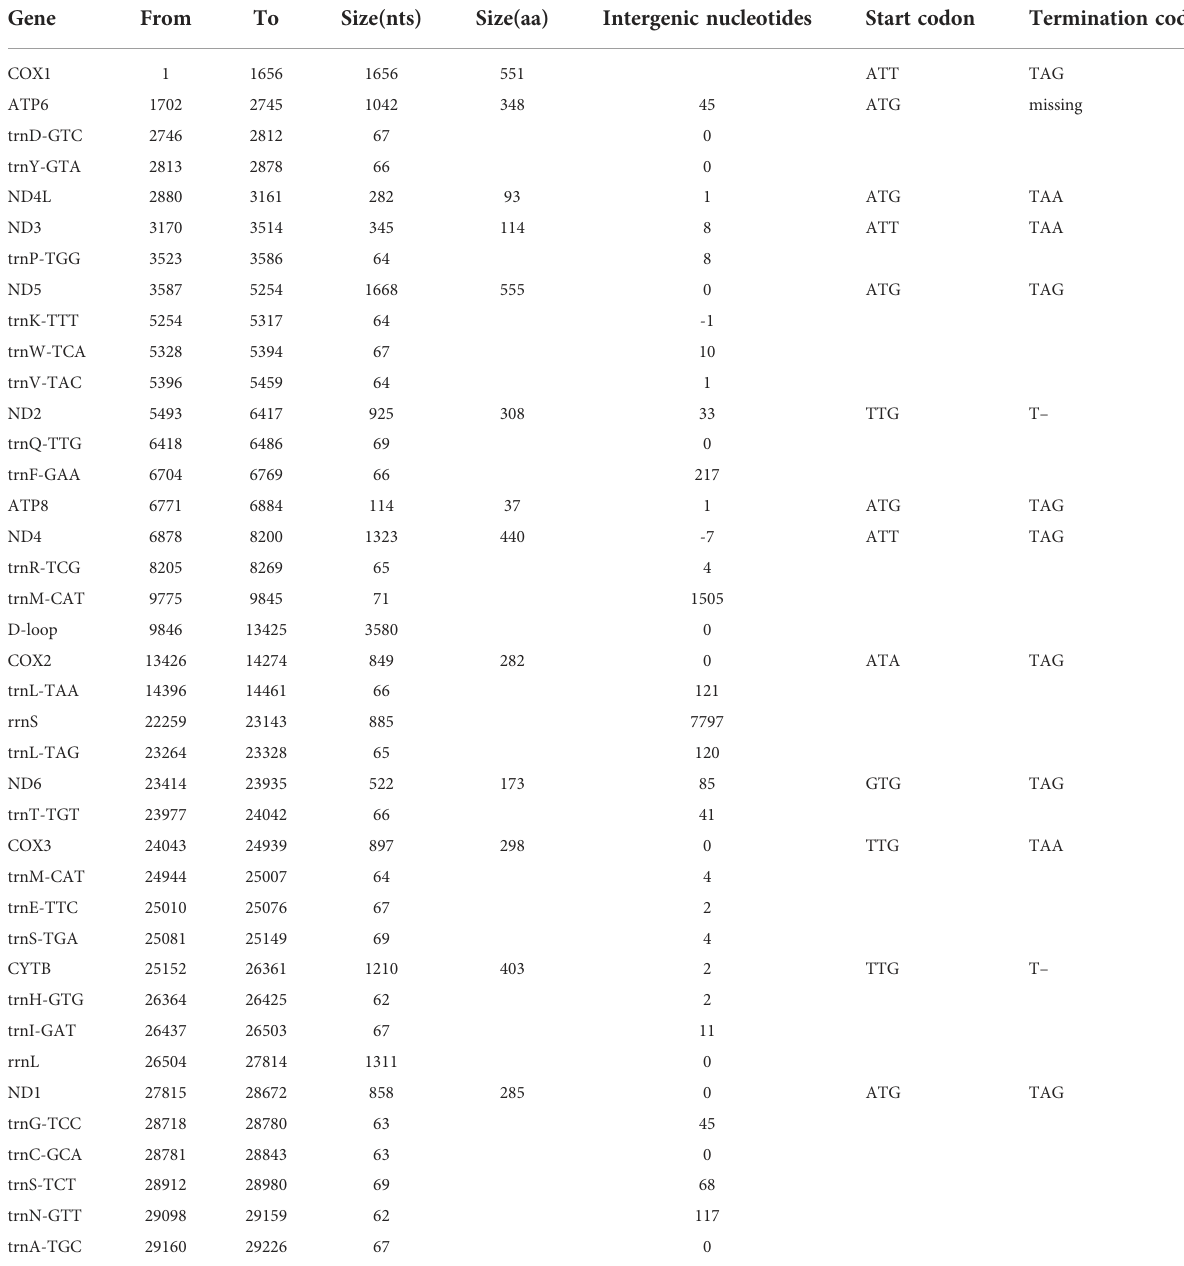
TABLE 2 Organization of the mitochondrial genome of H. porcellanus (29,434bp). Gene From